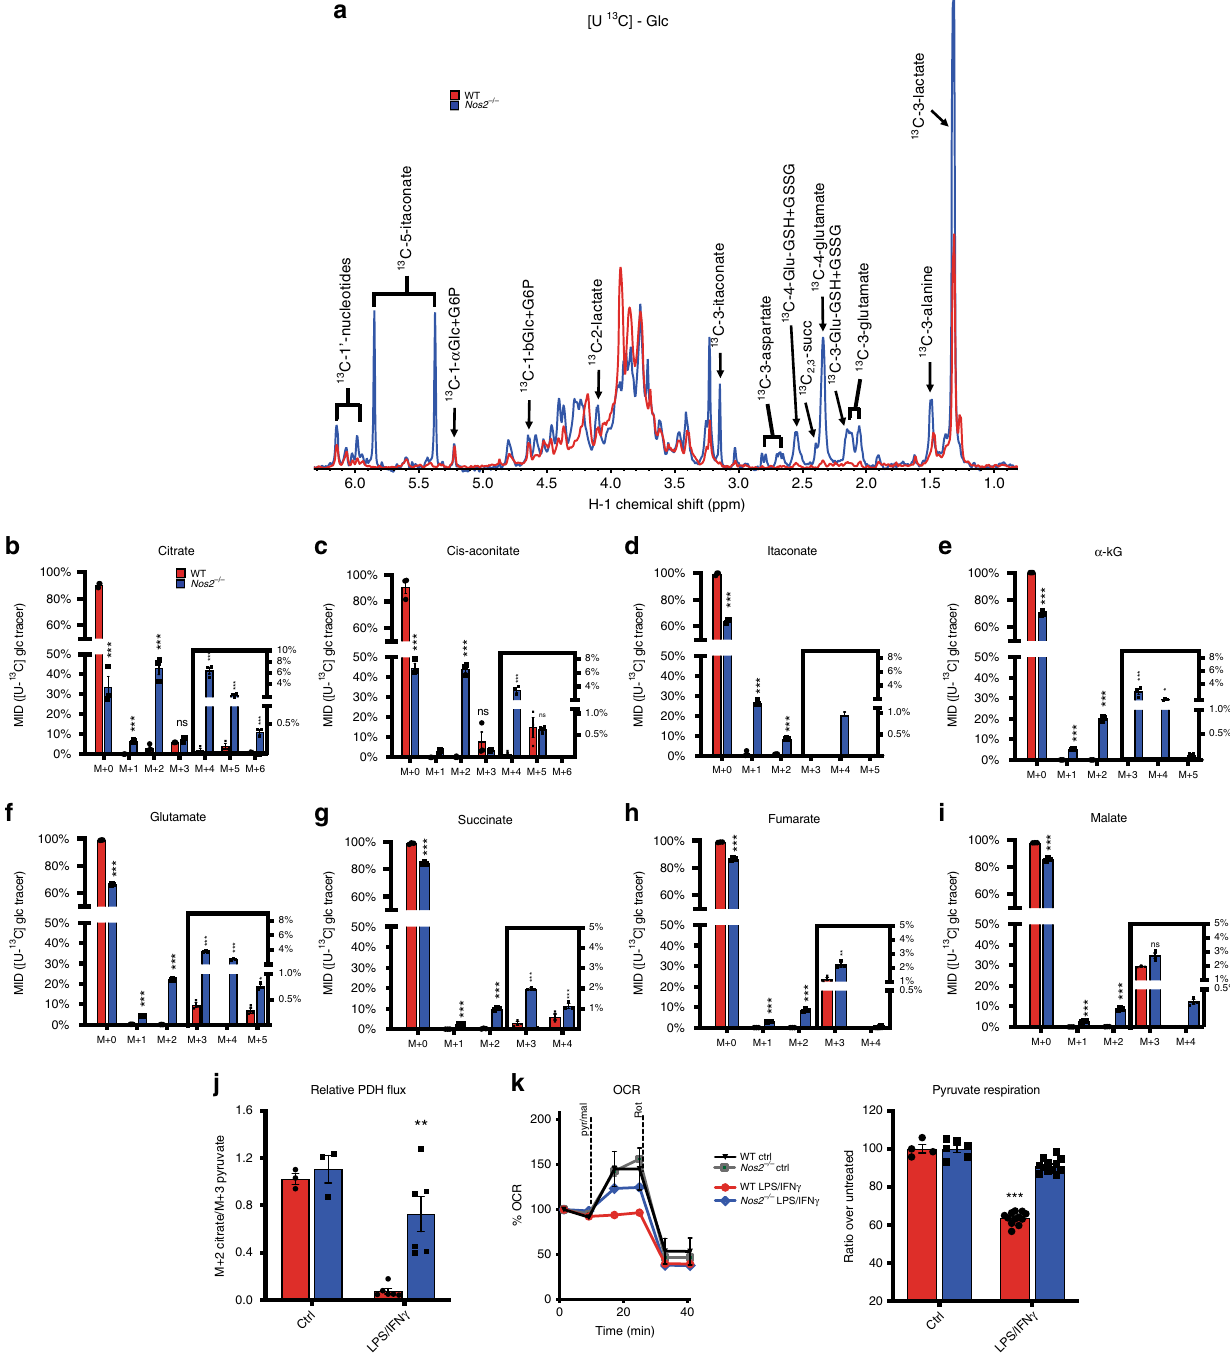
Fig. 3 Absence of NO promotes pyruvate oxidation via PDH. a Polar extracts from WT and Nos2 − / − BMDMs cultured with [U- 13 C] glucose were analyzed by 1D 1 H{ 13 C}_HSQC NMR. Spectral comparisons of stimulated cells are superimposed and show labeled TCA-derived metabolites in WT (red) vs. Nos2 − / − (blue). Spectra are representative of two experiments ( n = 6). b – i MID from GC-MS analysis of citrate, cis-aconitate, itaconate, α -kG, glutamate, succinate, fumarate, and malate. m + 0 to m + 6 reveal the contribution of glucose-labeled metabolites when TCA cycle can run multiple turns. Data ( n = 6) were analyzed by two-way ANOVA (interaction < 0.0001) (Sidak ’ s post-tests). j , k show fl ux through PDH. J Ratio of m + 2 citrate/ m + 3 pyruvate indicating relative oxidation through PDH. Bar graphs represent pooled data ( n = 6) and were analyzed by two-way ANOVA (interaction p = 0.0075) with Tukey ’ s post-tests. k Representative Seahorse analysis of permeabilized BMDMs where state 3-OCR was elicited by a mixture of pyruvate and malate to measure PDH fl ux. Bar graphs show quanti fi ed respiration in O.N. activated WT and Nos2 − / − BMDM ( n = 9) as percentage of OCR relative to untreated. Data ( n = 6) were analyzed by two-way ANOVA (interaction < 0.0001) (Sidak ’ s post-tests). All error bars display mean ± SEM. Source data are provided as a Source Data fi